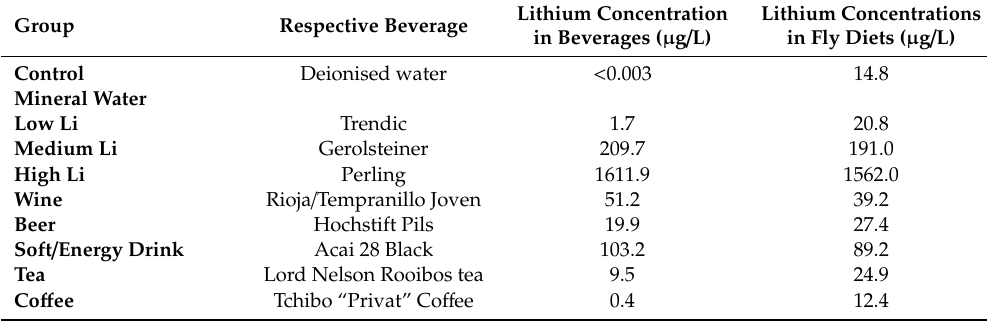
Table 2. Experimental design of the feeding study in Drosophila melanogaster . Experimental diets were prepared using eight respective beverages and deionized water as control. Flies were fed the experimental diets for seven days ( n = 4–8 independent experiments per group, comprising 100 flies / group).